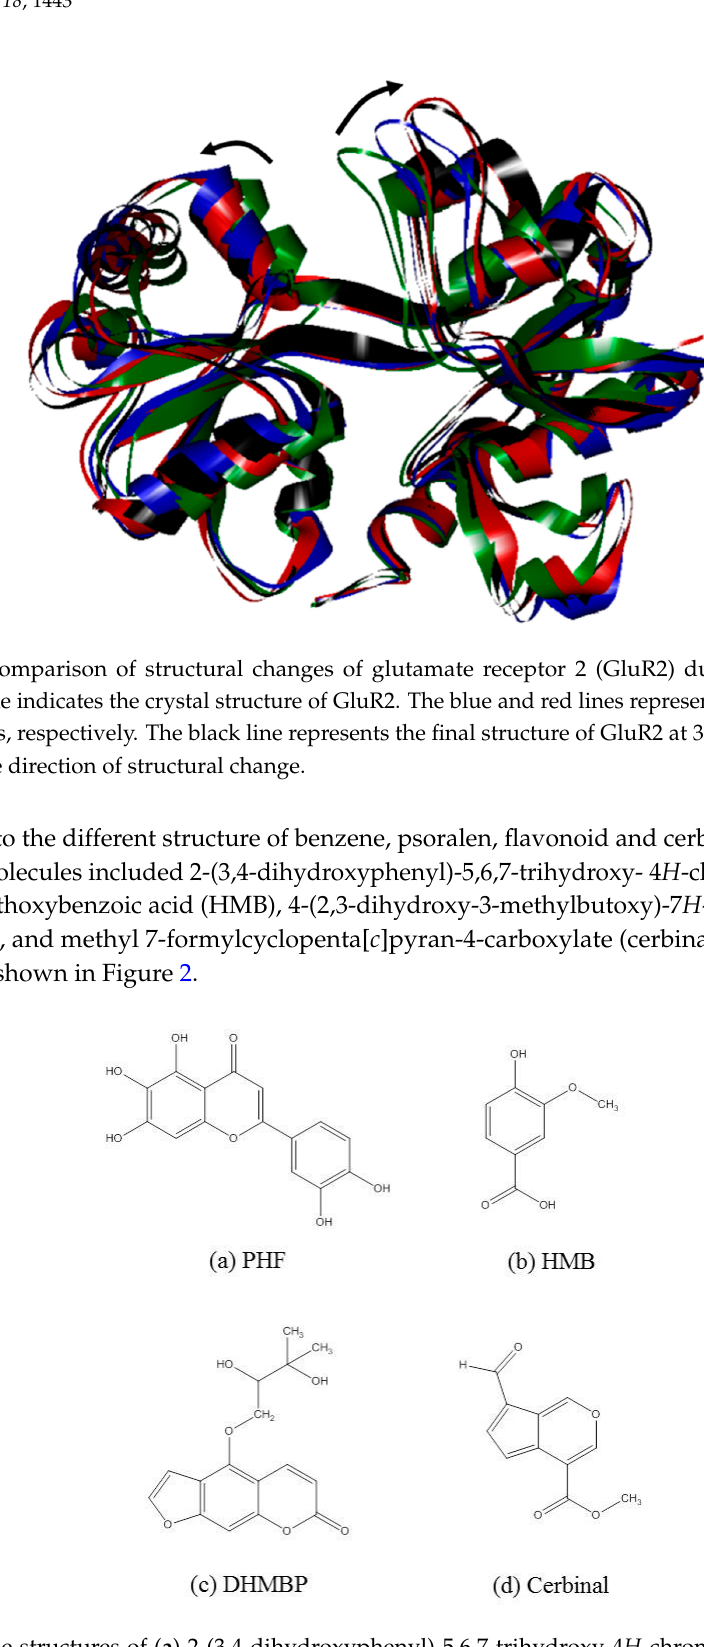
Figure 2. The structures of ( a ) 2-(3,4-dihydroxyphenyl)-5,6,7-trihydroxy-4 H -chromen-4-one (PHF); ( b ) 4-hydroxy-3-methoxybenzoic acid (HMB); ( c ) 4-(2,3-dihydroxy-3-methylbutoxy)-7 H -furo[3,2-g] chromen-7-one (DHMBP); and ( d ) methyl 7-formylcyclopenta[ c ]pyran-4-carboxylate (Cerbinal) molecules in